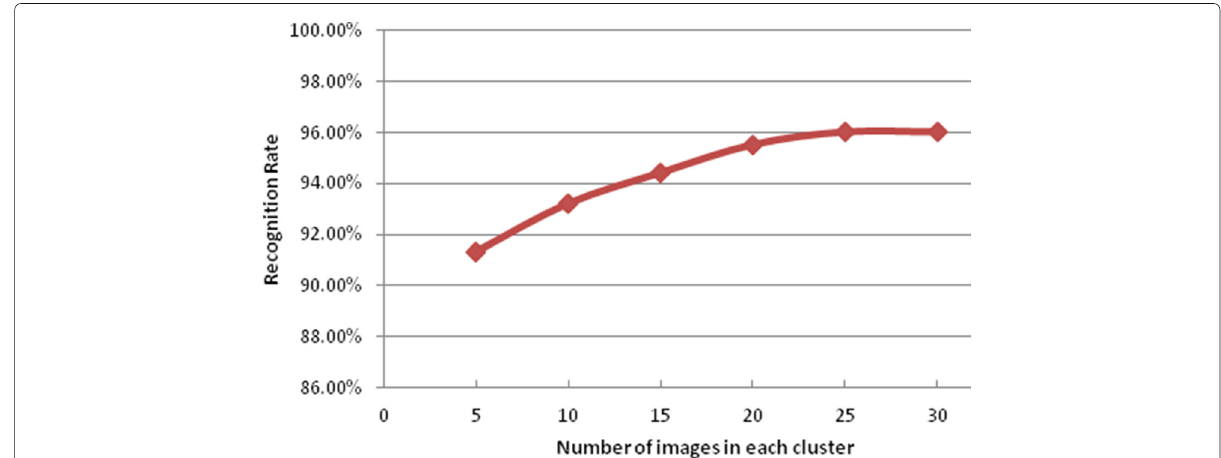
Fig. 18 Classification rates (500 ligatures) as a function of number of images in each ligature cluster